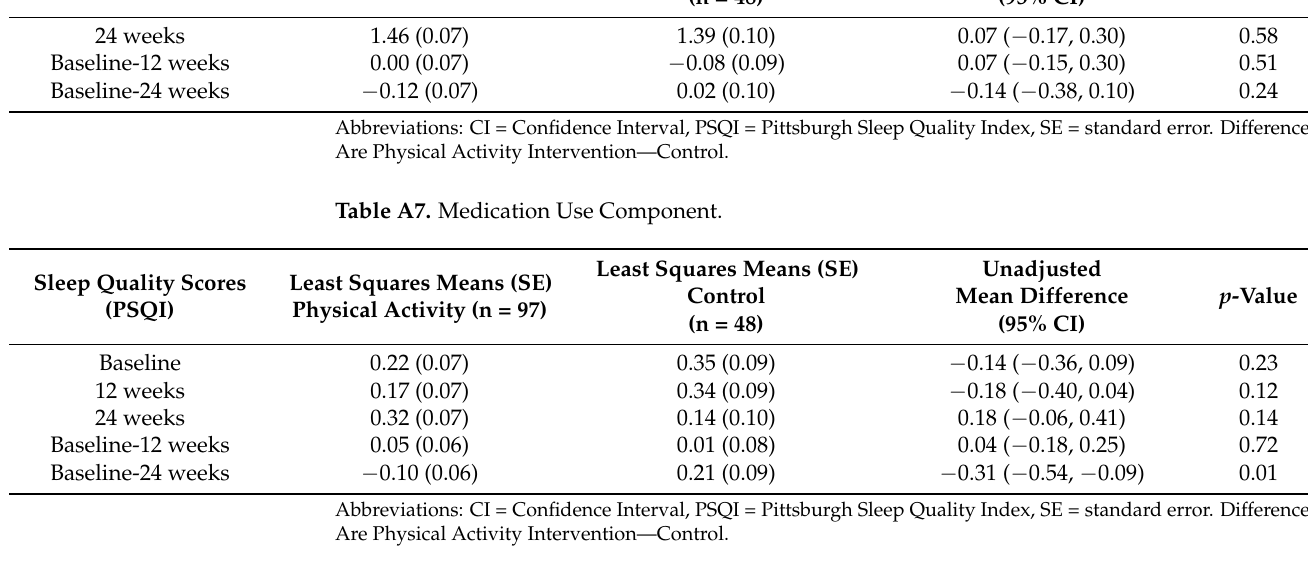
Table A8. Daytime Dysfunction